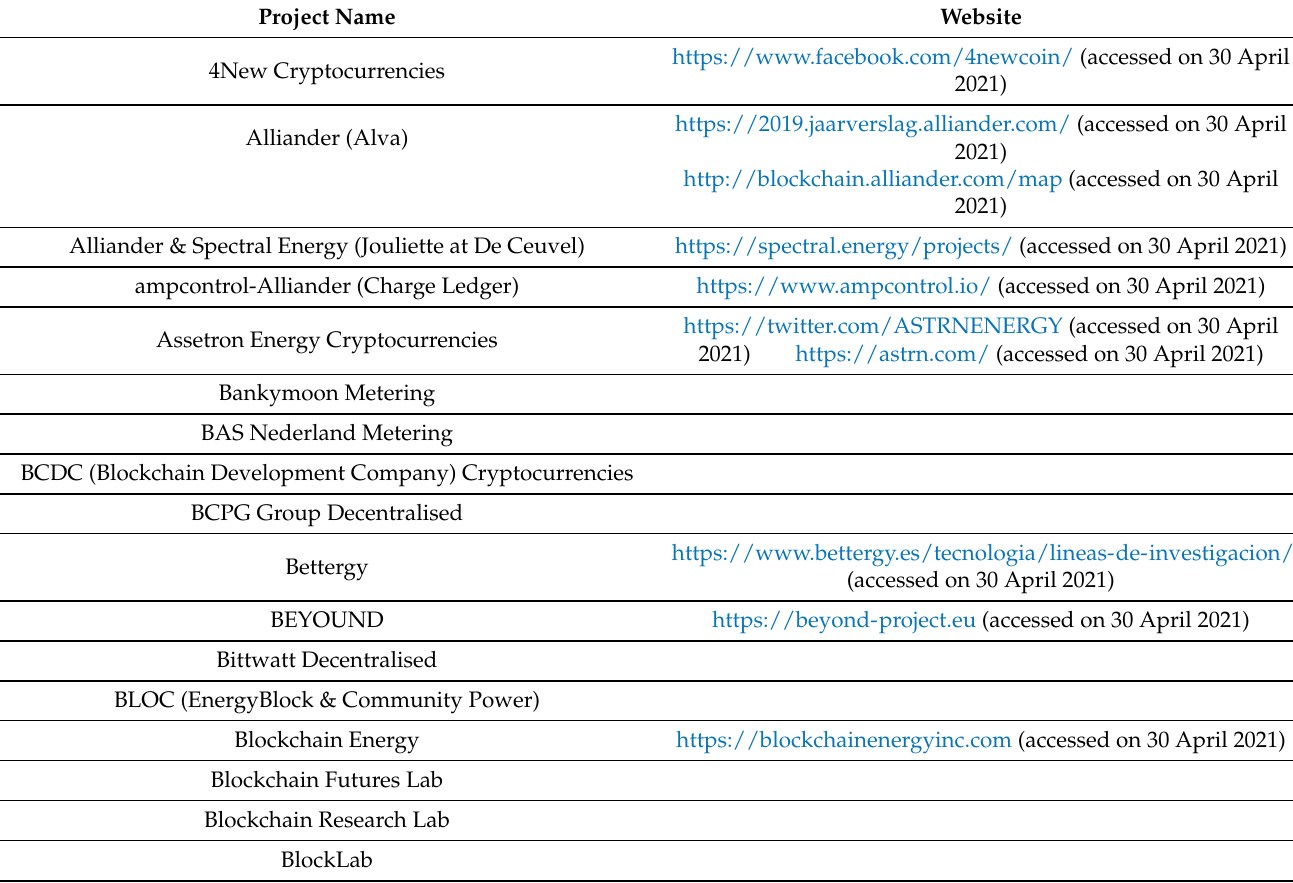
Table A1. P2P, TE and CSC projects and